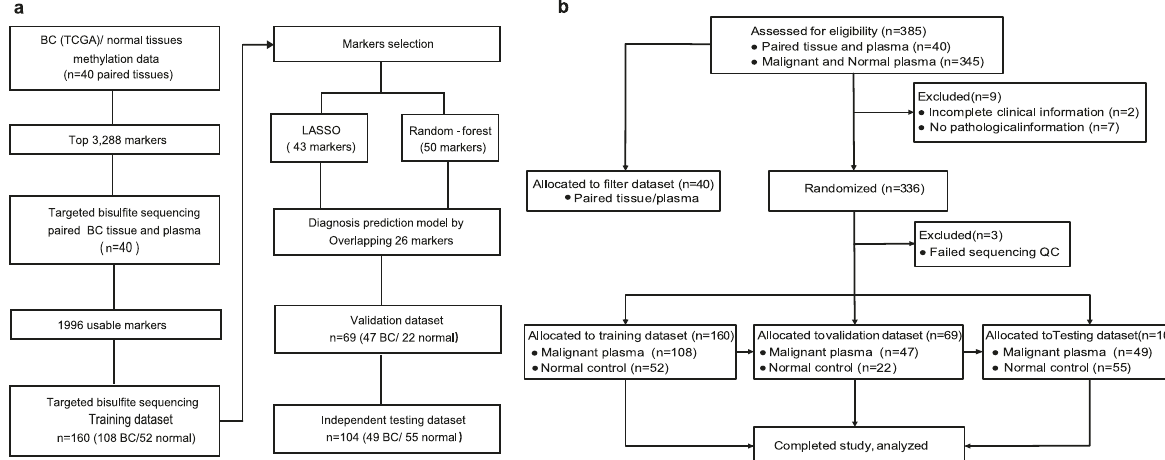
Fig. 1 Work fl ow of the study design and Consort diagram. a The breast cancer (BC) methylation panel targets were speci fi cally selected as those areas with differences in methylation between tumour and normal tissue based on The Cancer Genome Atlas (TCGA) data. Forty paired tissue and plasma samples were used to identify a total of 1996 methylation pattern markers. Targeted methylation pro fi ling for cancer/normal classi fi cation was performed as follows: LASSO and random forest analyses were applied to a training cohort of 52 normal controls and 108 breast cancer patients to identify a fi nal selection of 26 markers. These 26 markers were applied to a validation cohort of 22 normal controls and 47 breast cancer patients. The fi nal performance of our models was tested in an independent test cohort of 55 normal controls and 49 breast cancer patients. b Participants screened and enrolled. QC quality criteria. Samples in tissue and plasma underwent targeted capture-probe sequencing via high-throughput sequencing with the ultrasensitive AnchorIRIS TM assay. Our goal was to select enough controls and malignant plasma, but due to the available clinical information of samples and exclusion criteria, we were not able to identify all assessed samples that entered the analysis. Finally, 40 pairs of breast cancer tissue DNA and matched plasma cfDNA were used for fi ltering, and 336 plasma cfDNA were randomly assigned to a training group ( n = 160), validation group ( n = 69) and independent testing group ( n = 104).